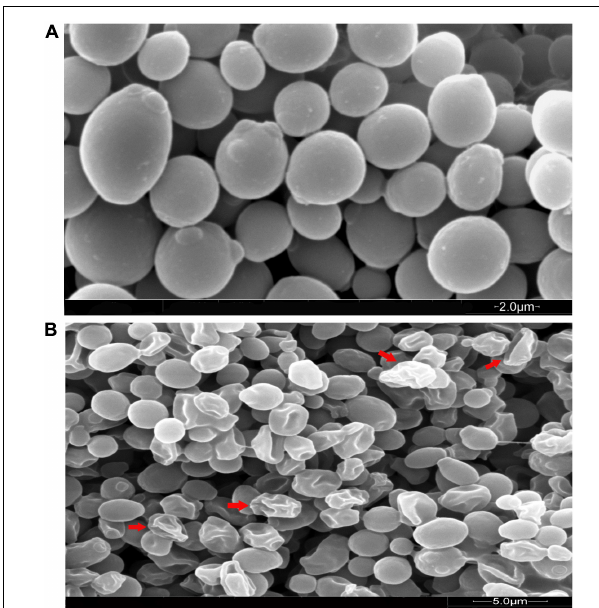
FIGURE 6 | Transmission electron microscopy of C. albicans cells treated with MCh-AMP1. Approximately 1 × 10 6 yeast cells were incubated without ( A , control) or with MCh-AMP1 (32 µ g/mL) (B) for 3 h. (A) Untreated C. albicans cells showed intact cell walls (black wide arrows), cell membranes (black narrow arrows) and organelles (red arrow). (B) Exposure to MCh-AMP1 resulted in morphological changes including loss of the structural integrity of the cell membrane and shrunk cytoplasm membrane detached from the cell wall (black narrow arrows), cytoplasmic depletion of fungal cells and destruction of intracellular organelles especially cell mitochondria (red arrows). The cell wall was not affected by the peptide (black wide arrow).